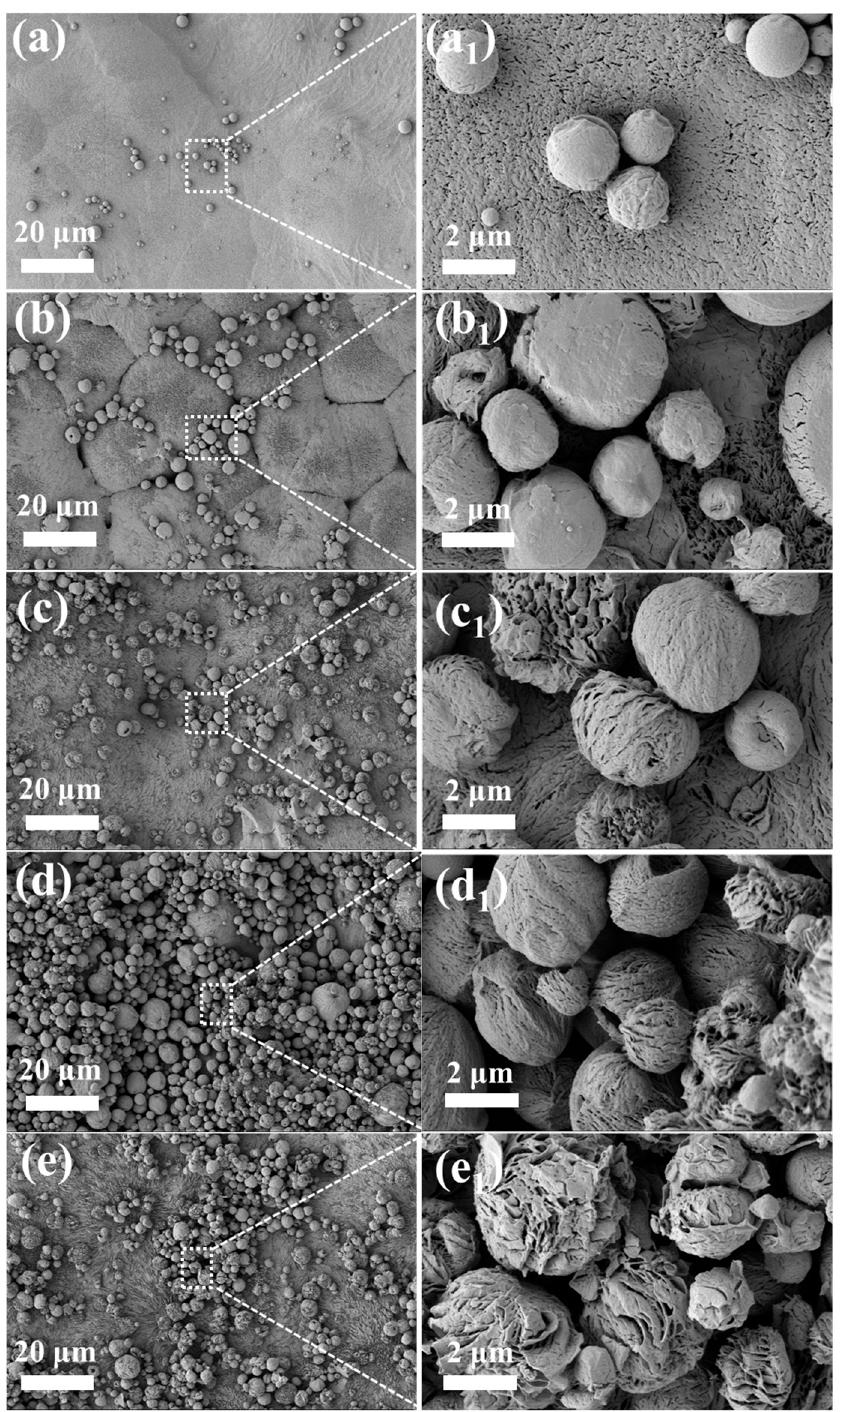
Figure 4. SEM images of ( a , a 1 ) pure PLLA, ( b , b 1 ) 1 wt% PLLA/FA@KH570, ( c , c 1 ) 3 wt% PLLA/FA@KH570, ( d , d 1 ) 5 wt% PLLA/FA@KH570, and ( e , e 1 ) 7 wt% PLLA/FA@KH570 composites. The particular mechanism for the construction of hierarchical microstructures via the solvent-volatilization-induced phase separation approach is vividly modeled in Figure 5. The phase separation would take place when the Gibbs free energy of the PLLA solution violently fl uctuated. In this investigation, the solution would be strati fi ed as a result of the density di ff erence between the solvent (dichloromethane, 1.33 g/cm 3 ) and nonsolvent (eth- anol, 0.79 g/cm 3 ). Since dichloromethane volatilized much more quickly than ethanol, con- centration fl uctuation appears at the solvent/nonsolvent interface, resulting from PLLA